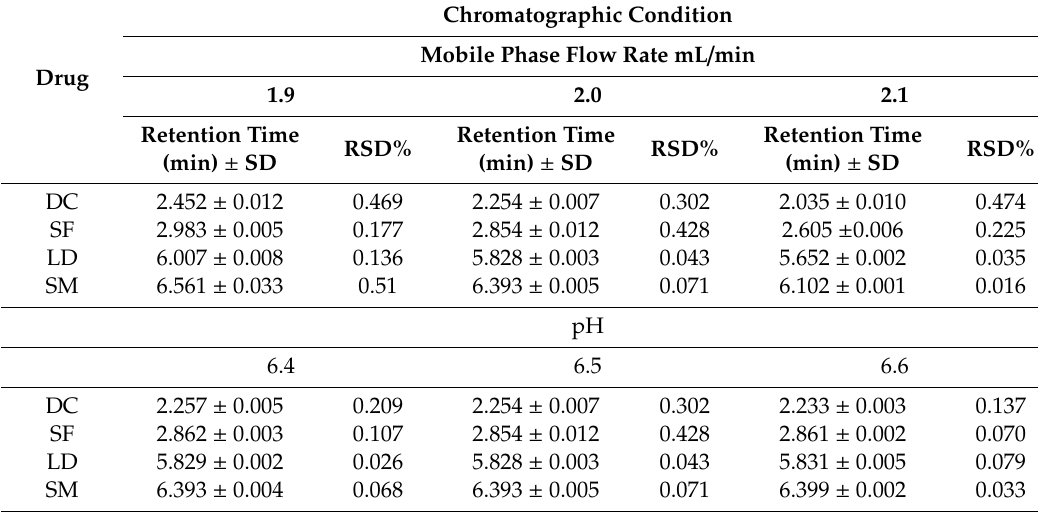
Table 4. Results of robustness